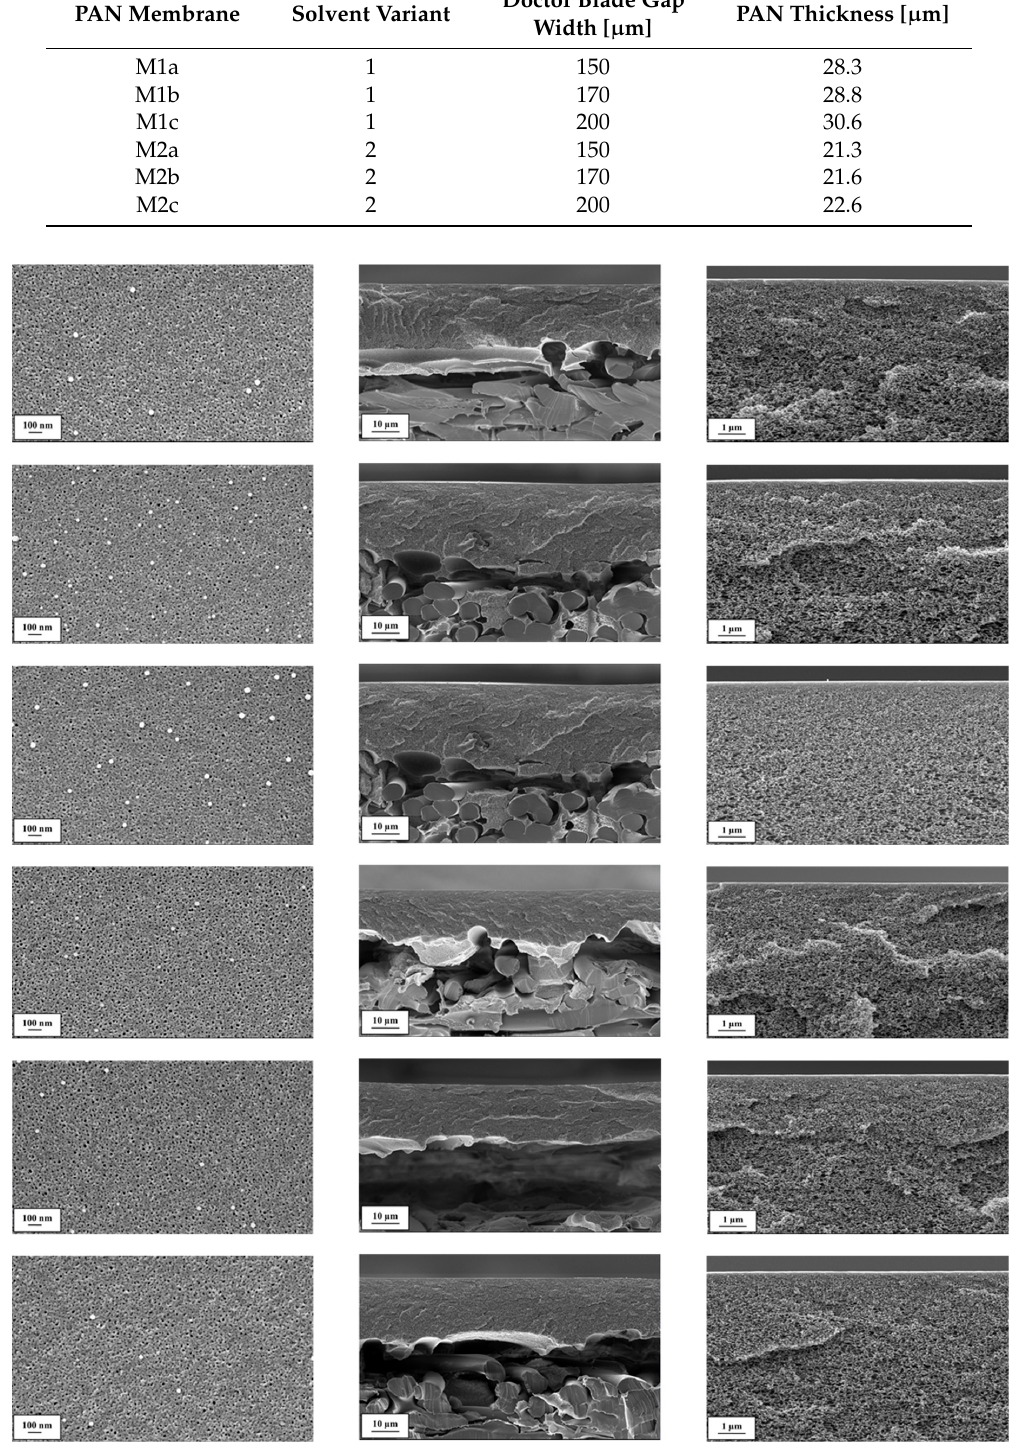
Figure 1 . Scanning electron microscope (SEM) images of PAN membranes M1a, M1b, M1c, M2a, M2b and M2c (top to bottom) of ( left ) membrane surface, ( middle ) membrane cross-section and ( right ) membrane cross-section at higher magnification.